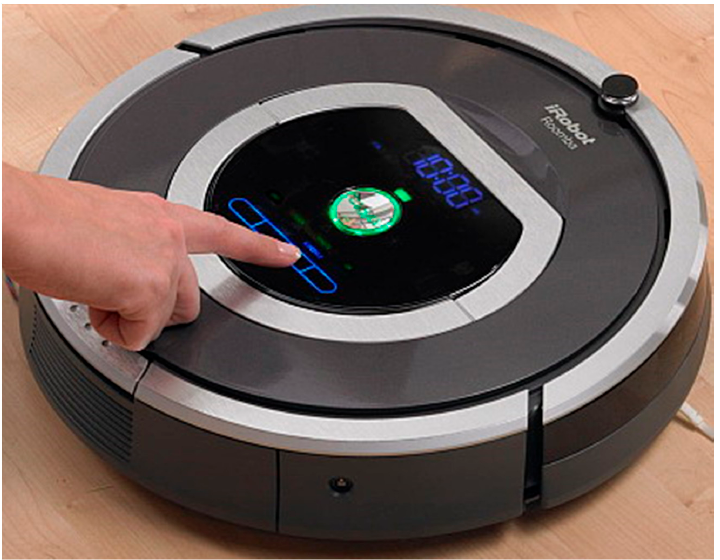
Multimodal Technol. Interact. 2017 , 1 , 12 Figure 2. A photograph of the new robot vacuum cleaner iRobot Roomba 700 Series. Image by Nohau. CC BY-SA 3.0; https://commons.wikimedia.org/wiki/File: Робот _ пылесос _Roomba_780.jpg. Cropped and resized to fit.